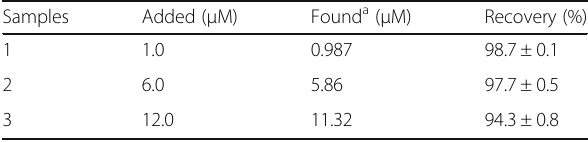
Table 3 Determination of paracetamol in human urine samples Samples Added ( μ M) Found a ( μ